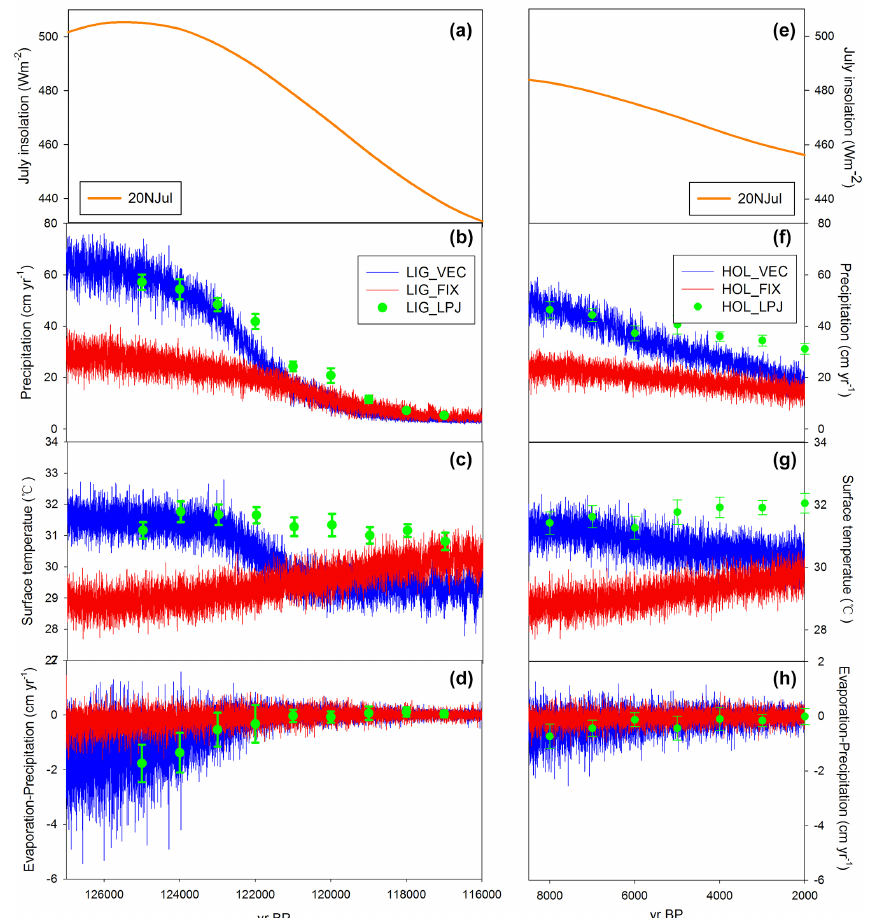
Figure 1. Evolution of 20 ◦ N July insolation, North African precipitation, surface temperature, and values of evaporation minus precipitation during the LIG (a, b, c, d) and Holocene (e, f, g, h) . Our target area is delimited by 10 ◦ W to 35 ◦ E and 15 to 30 ◦ N. The blue lines and red lines are simulated results from transient experiments with dynamical vegetation and fixed pre-industrial vegetation, respectively. The green dots with error bars are simulated results from experiments with asynchronously coupled “dynamical”